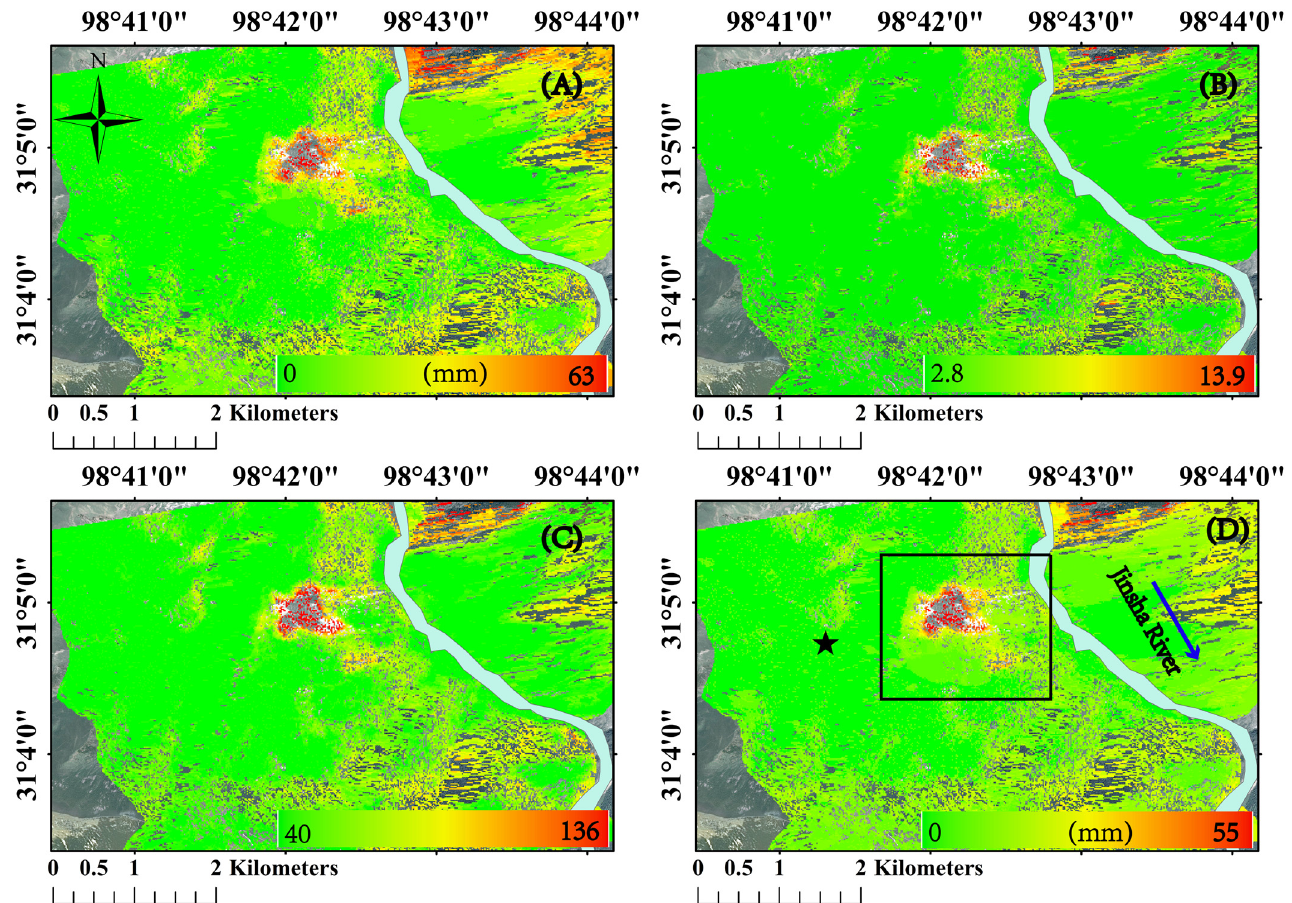
Figure 9. Quality assessment of deformation parameters. ( A ) Sum of the residual; ( B ) average value of trace of cofactor matrix; ( C ) number of redundant interferograms; ( D ) average of the STD of the deformation time series in the Markov model for phase unwrapping. The winding polygon is the Jinsha River.